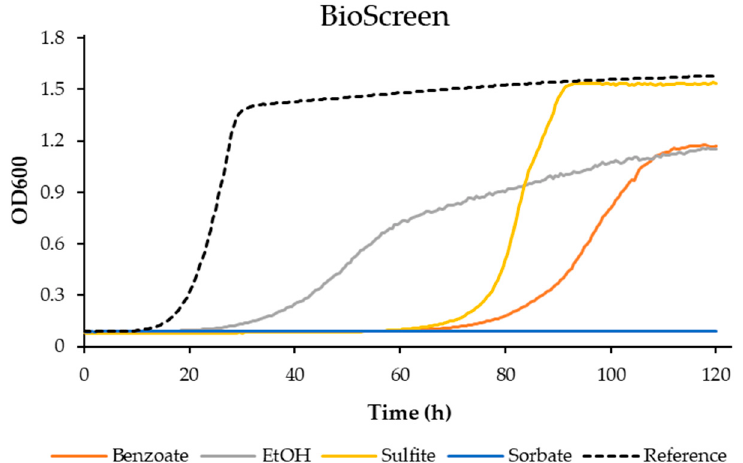
Figure 6. The effects of different preservatives on the growth (OD600) of Z. florentina in microplate cultivations. The curves are the means of three replicates. For deviation between the replicates, please see the supplementary material.